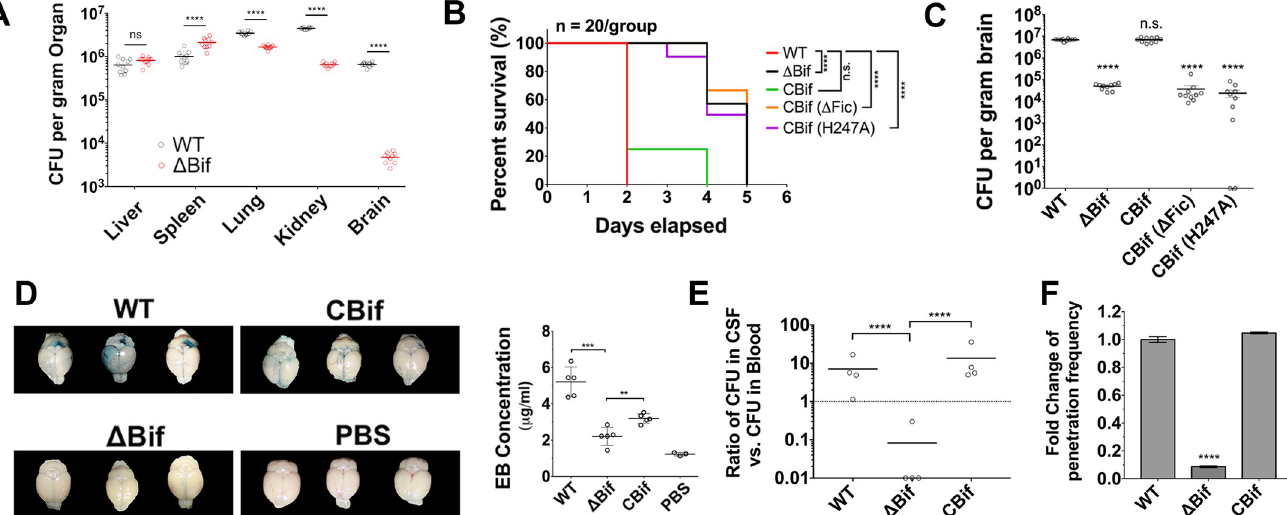
Fig 1. BifA enhances SEZ virulence, brain colonization and disrupts the BBB. (A) Recovery of WT or Δ Bif CFU from the indicated organs of BALB/c mice 48 hr after i.p. challenge with 1 × 10 5 CFU of either SEZ strain ( ���� indicates p-value < 0.0001 with t test). (B) Survival curves of BALB/c mice after i.p. challenge with 5 × 10 5 CFU WT, Δ Bif, or Δ Bif complemented with WT BifA (CBif), or BifA deleted for the Fic domain (CBif ( Δ Fic)), or a BifA H247A substitution mutant (CBif (H247A)). Each group contains 20 mice ( ���� indicates p value < 0.0001 with Log-rank Test vs WT). (C) Burdens of indicated strains in mouse brains 2 days post i.p. challenge with 5 × 10 5 CFU, 10 mice/group ( ���� indicates p-value < 0.0001 with t test). (D) Evans Blue (EB) permeability in brains of mice infected with the indicated strains. Mice were inoculated with EB 18 hours after they were i.v. inoculated with 5 × 10 6 CFU of WT, Δ Bif or CBif. Six hours later, brains were dissected and EB was extracted and quantified ( �� indicates p-value < 0.01 and ��� indicates p-value < 0.001with t test). (E) Ratio of bacterial burdens in cerebrospinal fluid versus blood 12h post i.v. infection with indicated strains (4 mice/group, ���� indicates p-value < 0.0001 with t test). (F) WT and mutant SEZ traversal of hBMEC grown in transwell chambers. The Y-axis represents the percentage of bacteria that migrated from the upper to the lower chamber in 3 replicates ( ���� indicates p-value < 0.0001 with t test).